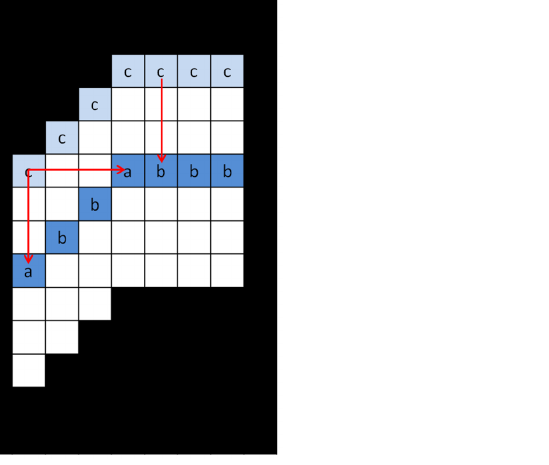
Figure 8. Principle diagram of bidirectional center of gravity method.